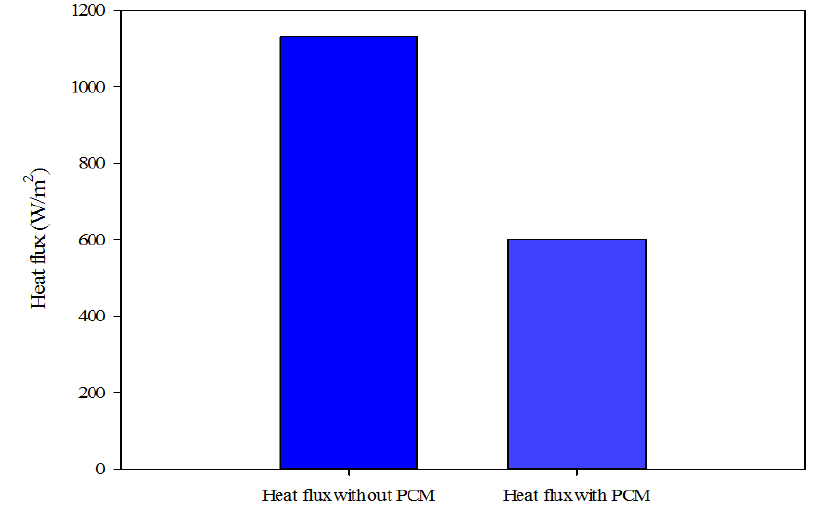
Figure 22. The simulated heat flux entering the room.